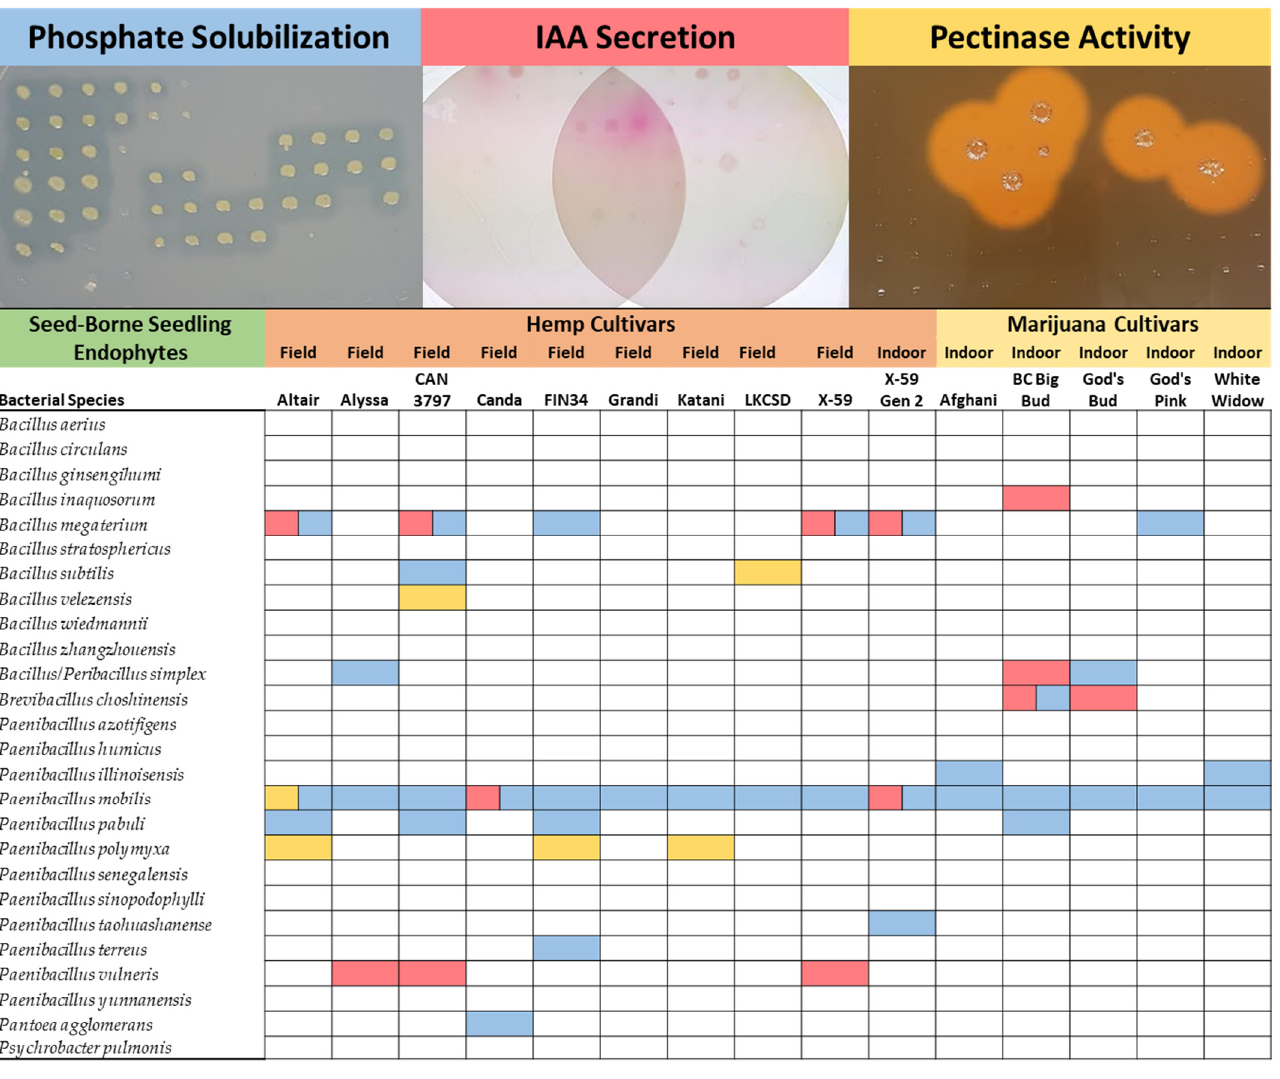
Figure 3. Summary of in vitro Phenotyping Assays. Cannabis endophytes were assayed for the po- tential to solubilize mineral phosphate, secrete IAA, and hydrolyze pectin. Blue squares indicate phosphate solubilization. Red squares indicate IAA secretion. Yellow squares indicate pectinase ac- tivity.